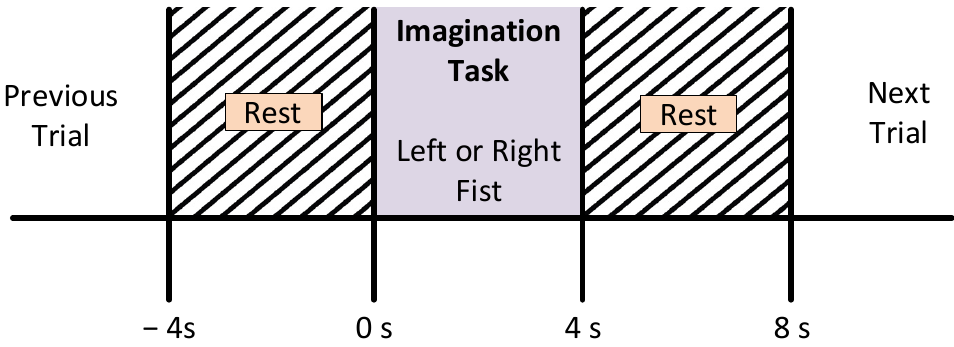
Figure 3. Motor imagery time scheme during the recording of the EEG